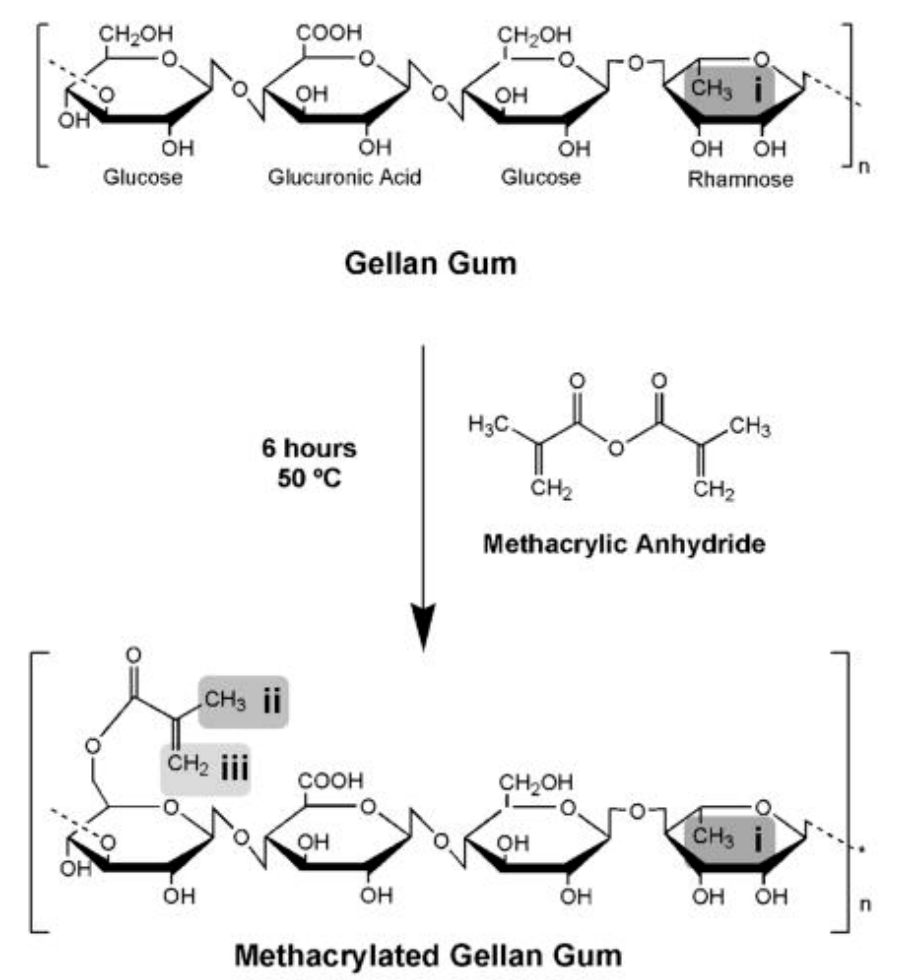
Figure 7. Synthesis of MeGG (i—methyl group of rhamnose, ii—methyl group of methacrylic anhydride, iii—vinyl group of methacrylic anhydride) Reprinted with permission from [106]. Copyright 2022, Elsevier